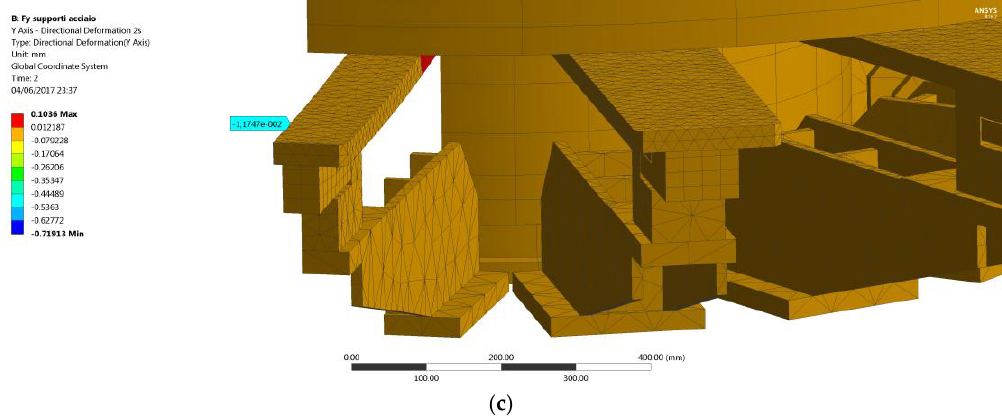
Figure 19. Overall FE displacements of the Transfer Machine with 15 divisions ( a ) Fz (−); ( b ) Fz (+); ( c ) Fy (−). The greatest displacement on the reference point is caused by the force Fy ( − ) ( ∆ y = 0.01 mm), while both Fz ( − ) and Fz (+) cause a displacement of 0.008 mm. The result reported in Table 5, for